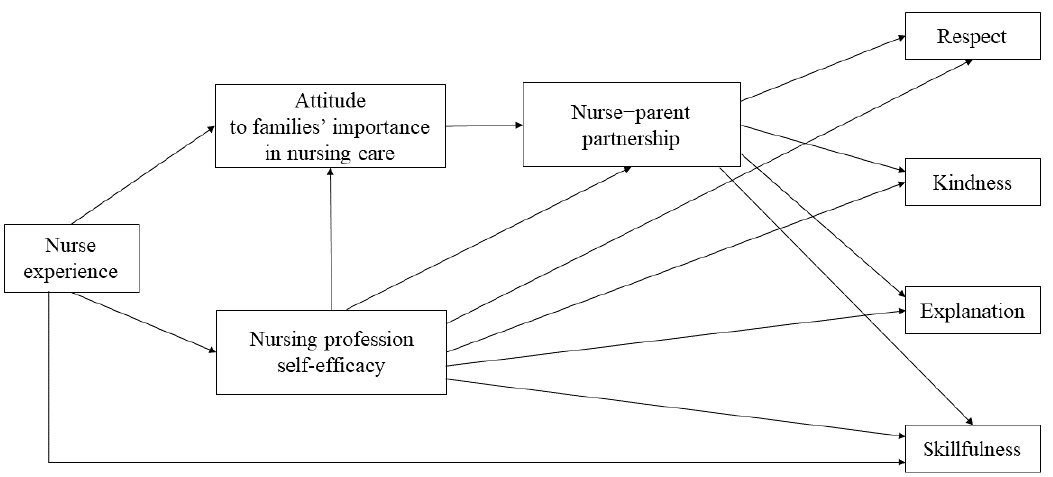
Figure 1. Hypothetical model of factors influencing quality of nursing care in the pediatric unit.